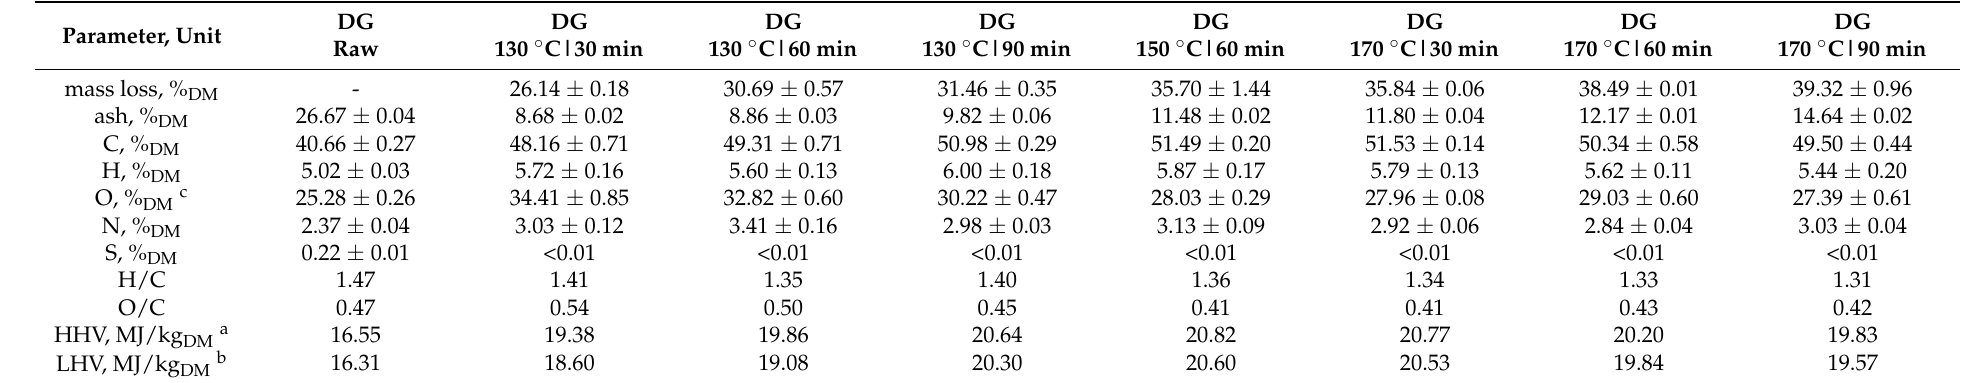
Table 3. Material properties of raw and hydrothermally treated digestate (DG) at 130, 150 and 170 ◦ C with a holding time of 30, 60 and 90 min. The dry matter (DM), higher heating value (HHV) and lower heating value (LHV) are shown. Mean values ± standard deviations.